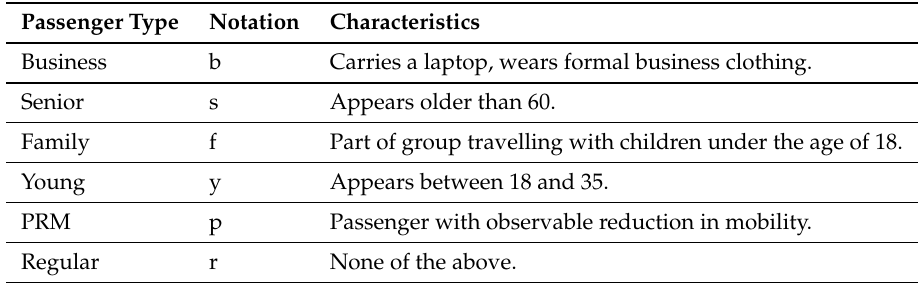
Table 3. The different passenger types as used in this work, and the observable characteristics based on which they were classified.